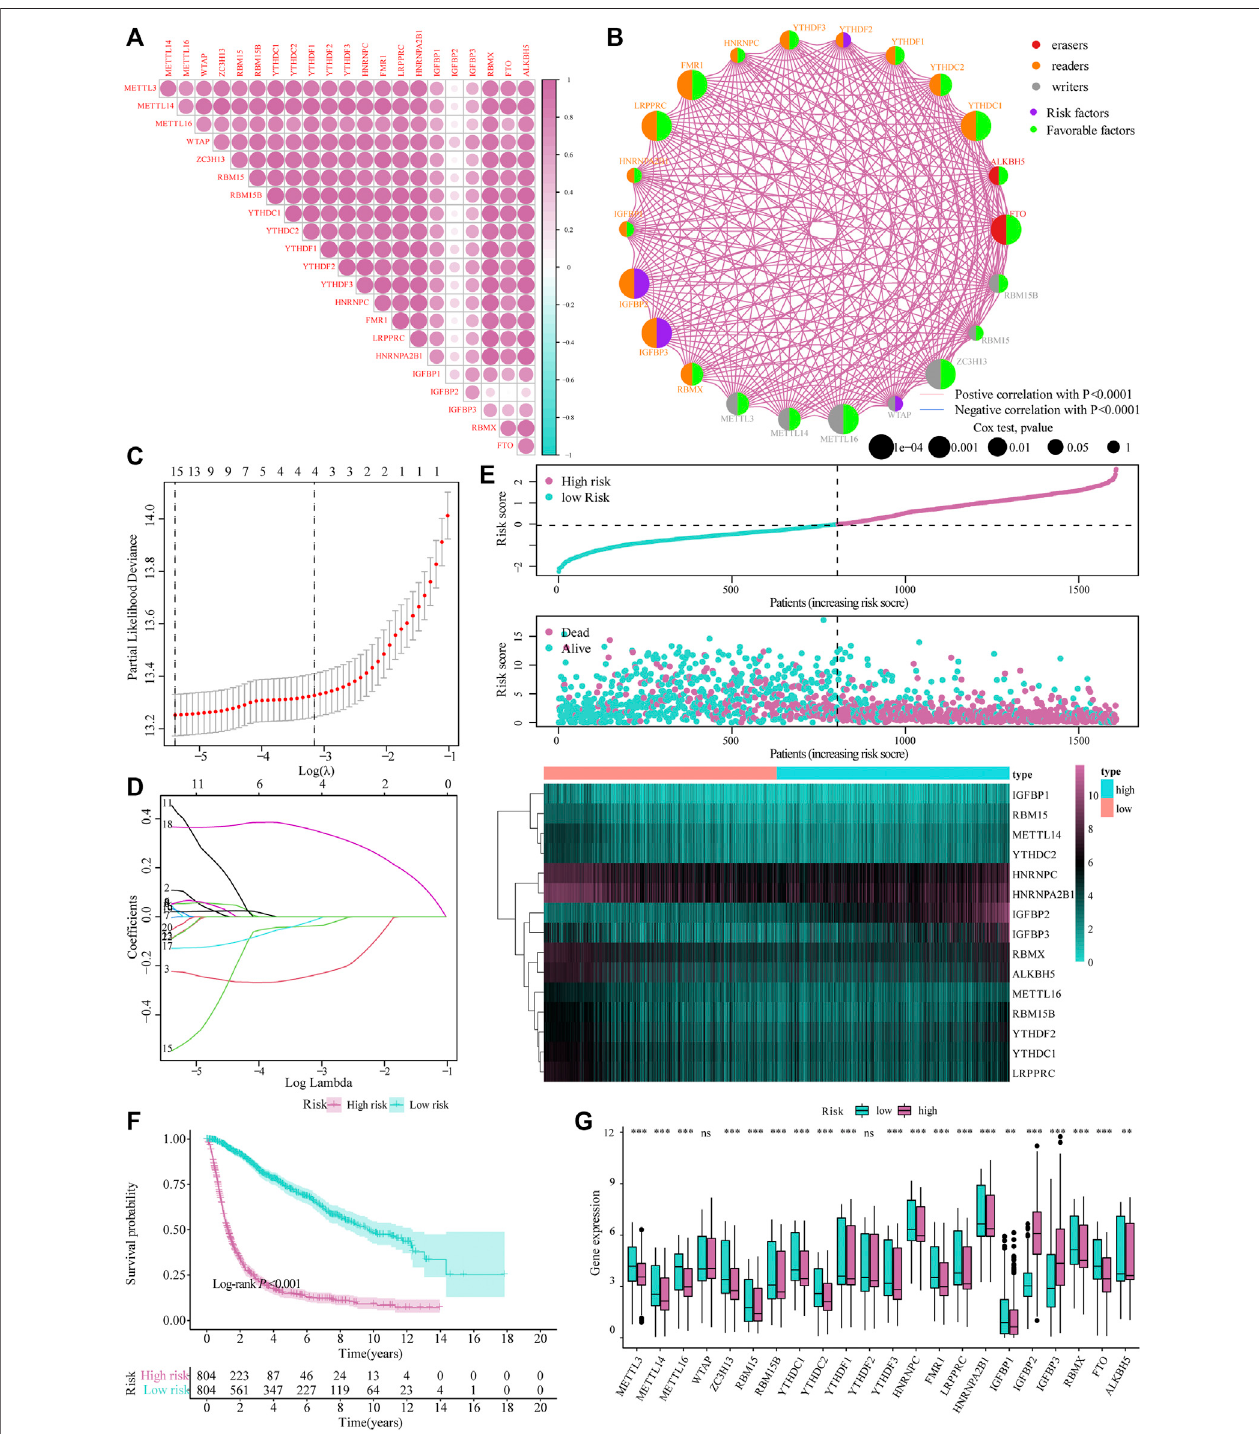
FIGURE2| Construction ofthem6Ariskscoringmodel. (A) Correlationanalysisofm6A-relatedgeneexpression inglioma; (B) Expressionand interaction ofm6A- relatedgenesingliomapatients.Thesizeofeachcellrepresentstheimpactofeachgeneonthepatient ’ ssurvivalstatus,andthelog-ranktestwasusedforanalysis.Half of the color of the circle represents the grouping of m6A-related genes, and the other half represents the impact on the prognosis. Among them, m6A-related gene groups: Erasers, red; Readers, orange; Writers, gray. At the same time, purple represents risk factors in the impact on prognosis, and the green represents protective factors. The lines connecting m6A-related genes represent the interactions between genes. The thickness of the line represents the correlation strength estimatedbySpearmancorrelationanalysis,redthenegativecorrelations,andbluethepositive; (C,D) LASSOCoxanalysisidenti fi ed15genesmostrelevanttotheOSin the TCGA dataset; (E) The risk score distribution of glioma patients, the patient ’ s survival status and the heat map of characteristic gene expression; (F) Kaplan – Meier curve to assess risk score impact on the overall survival rate of glioma patients; (G) Differential expression of m6A-related genes at high and low m6A risks.